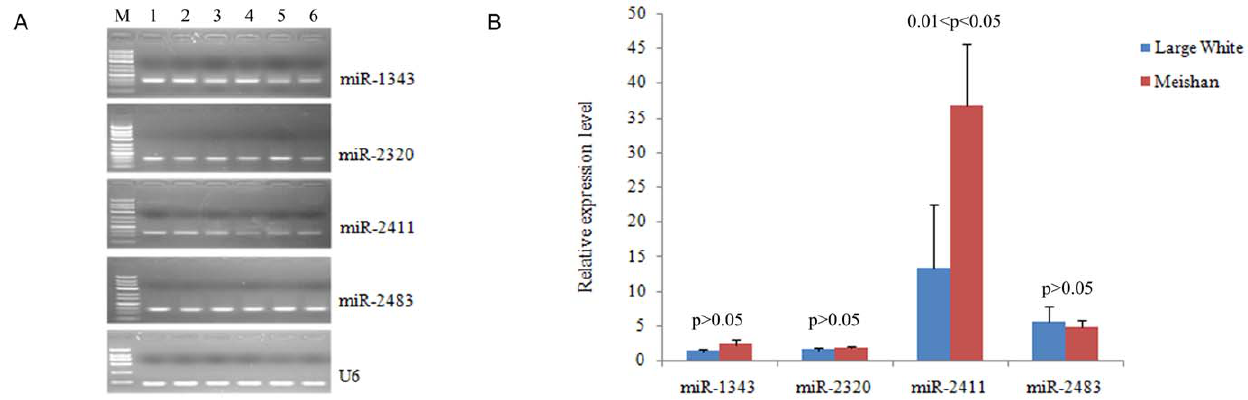
Figure 2. Four novel miRNAs were cloned and validated in porcine backfat tissue by stem-loop qPCR. A. miR-1343, miR-2320, miR-2411 and miR-2483 were cloned in porcine backfat tissue of Large White and Meishan samples. M represents DNA size marker, DL700 and DL2000. Large White samples (lane 1–3) and Meishan (lane 4–6) samples. U6 snRNA was used as an internal control. A 3% agarose gel, stained by ethidium bromide, was run to indicate the cloned miRNA because of the small product size, and the 1.5% agarose gel was used to indicate U6. B. The four novel miRNAs were validated by stem-loop qPCR. All experiments were performed three times. The data shown in Y-axis were calculated using the expression values of 2 2 DD Ct and expressed as means 6 standard error. The significance of differences for the expression between samples was calculated by one-way ANOVA. The corresponding significance value (p) was listed above their respective columns. 0.01 , p , 0.05 was considered to be significant. doi:10.1371/journal.pone.0031426.g002 PLoS ONE |